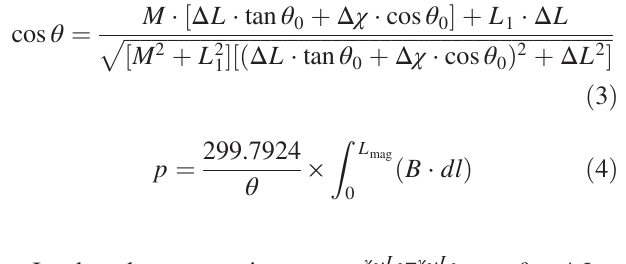
FIG. 18. Measured and simulated momentum spread for 6 GeV =c . A very good agreement with G4beamline is demon- strated. The Poissonian error bars have been multiplied by 10 for visualization